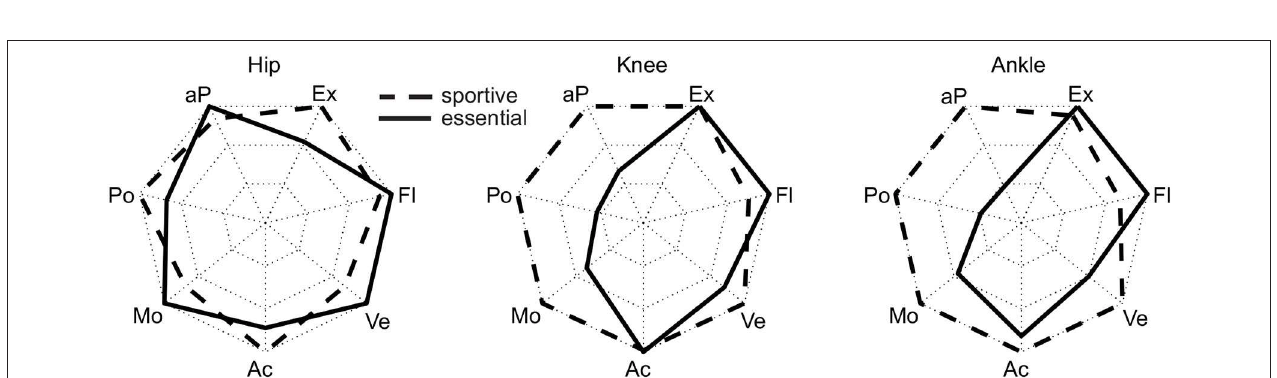
FIGURE 6 | Normalized maximum requirements for the essential (solid) and the sportive (dashed) movement tasks. The normalization was performed such that the maximum (sportive or essential) becomes 1, which represents the outer limit of the radar plot. The parameters are the maximum joint extension (Ex, at ankle plantarflexion), the maximum joint flexion (Fl, at ankle dorsiflexion), the maximum absolute angular velocity (Ve), the maximum absolute angular acceleration (Ac), the maximum absolute moment (Mo), the maximum absolute power (Po) and the maximum absolute average power (aP).